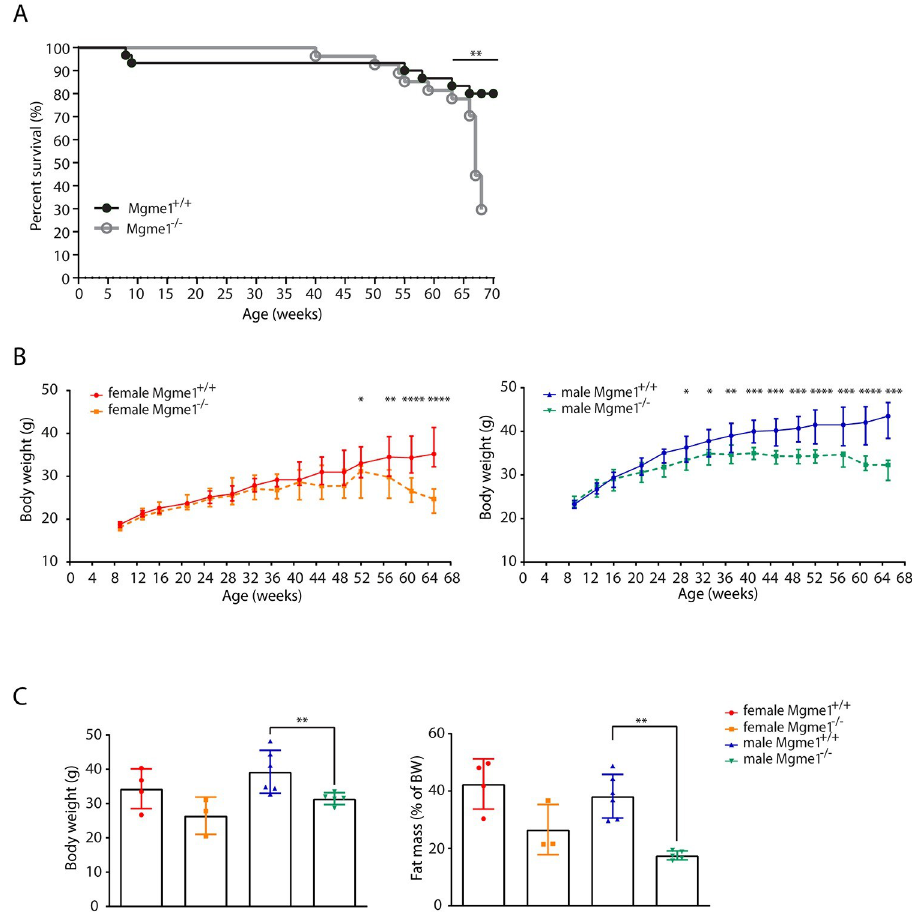
end of phenotyping protocol. (B) Mgme1 knockout mice do not gain weight as they age compared with controls and show progressive weight loss at the later time points, � P � 0.05, �� P � 0.01, ��� P � 0.001, ���� P � 0.0001 Unpaired Mann-Whitney Test. (C) Body weight measured at 68 weeks of age of n = 4 wild-type and 3 Mgme1 -/- females and 6 wild-type and 5 Mgme1 -/- males. Fat mass is indicated as percent of body weight. Values are given as mean ± SD, �� P � 0.01. Unpaired Mann-Whitney